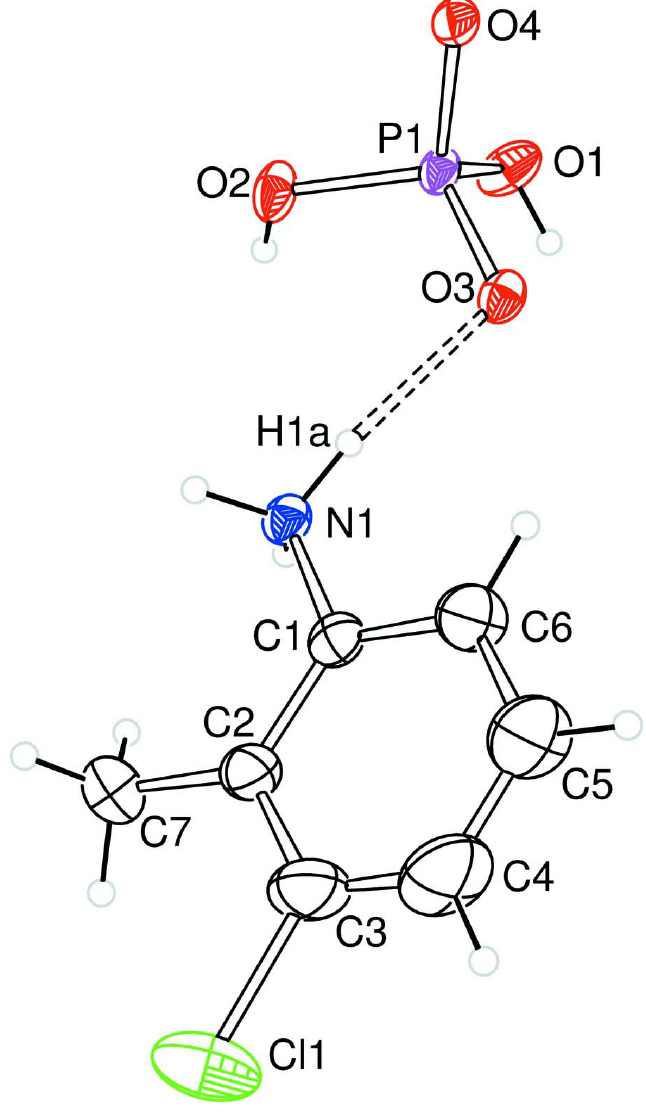
View of (I) with the atom-labelling scheme. Displacement ellipsoids are drawn at the 30% probability level. H atoms are represented as small spheres of arbitrary radii. H bond is shown as dashed